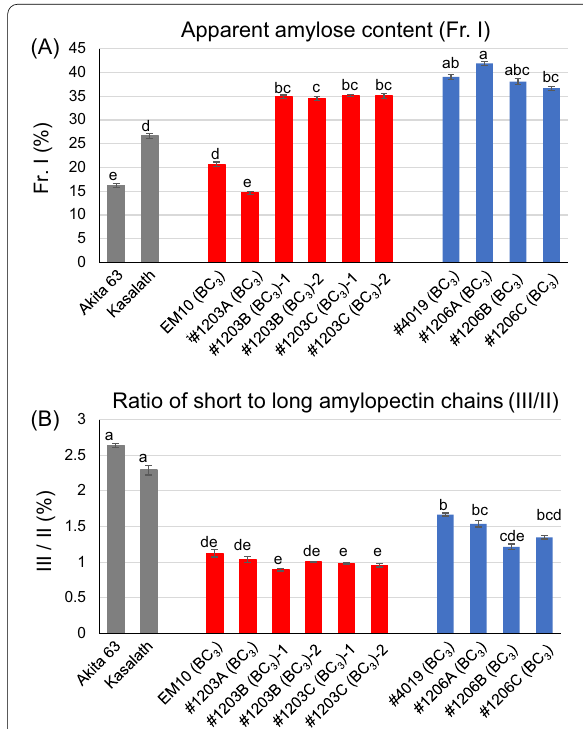
Fig. 3 Measurement of apparent amylose content by gel filtration chromatography using debranched starch. Fraction I contains amylose and extra-long chains of amylopectin; fraction II contains long chains of amylopectin; and fraction III contains short chains of amylopectin. a Apparent amylose content. b Ratio of short to long amylopectin chains, calculated by dividing fraction III value by fraction II value. Different lowercase letters indicate significant differences ( P < 0.05; Tukey–Kramer